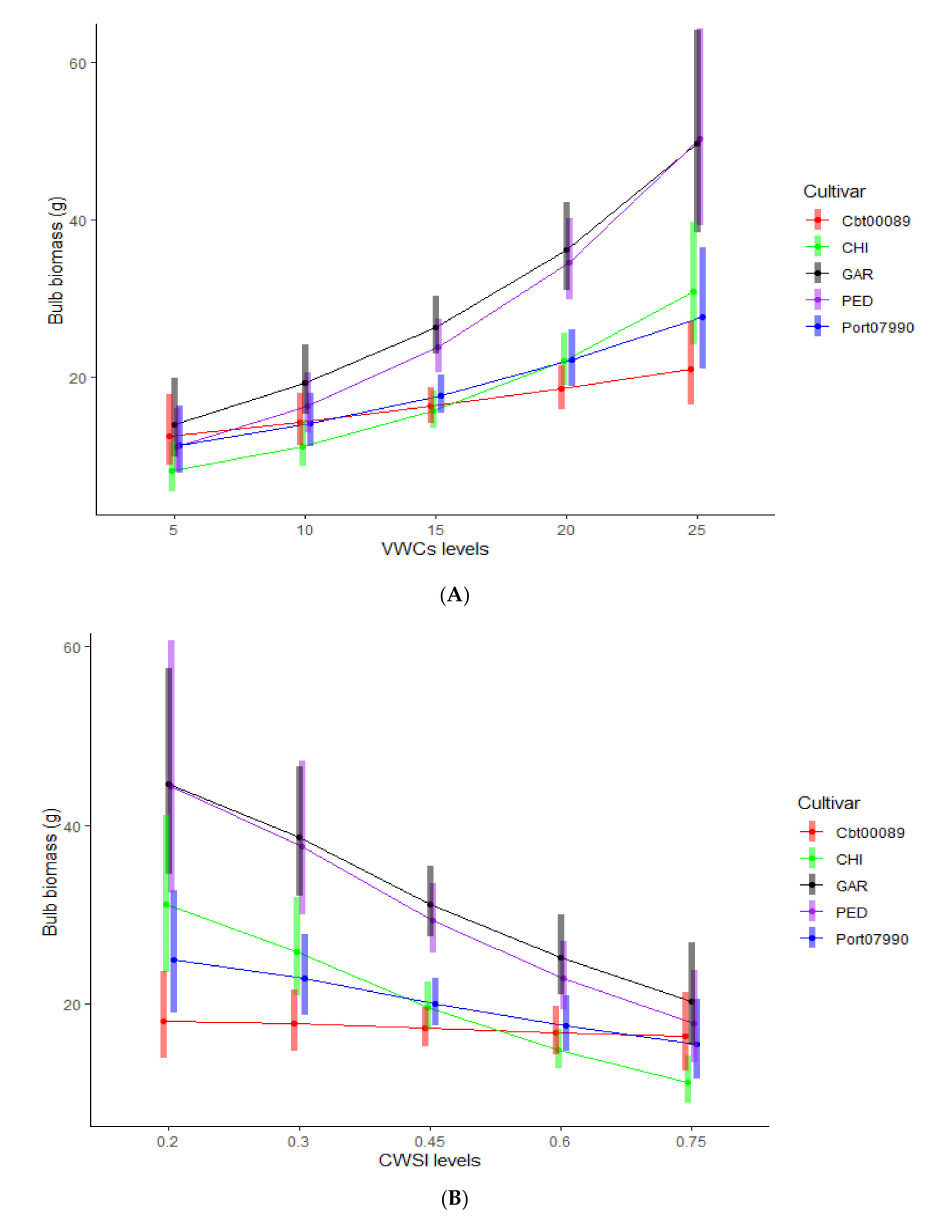
Figure 4. Bulb biomass-estimated marginal means (B-EMMs) for each cultivar of: ( A ) Model4 Cult*VWC across selected levels of soil volumetric water content (VWCs); and ( B ) Model4 Cult*CWSI across selected levels of crop water stress index (CWSI). Vertical bars are confidence intervals ( ± 95%) of the B-EMMs on each cultivar and selected level of VWCs or CWSI, respectively. The table below the figure are the slope means ± standard error of each Cultivar in the corresponding model. Letter codes indicate homogeneous groups at p < 0.05 (Tukey test) within the same model. ++ Slope confidence intervals ( ± 95%) not significantly di ff erent from